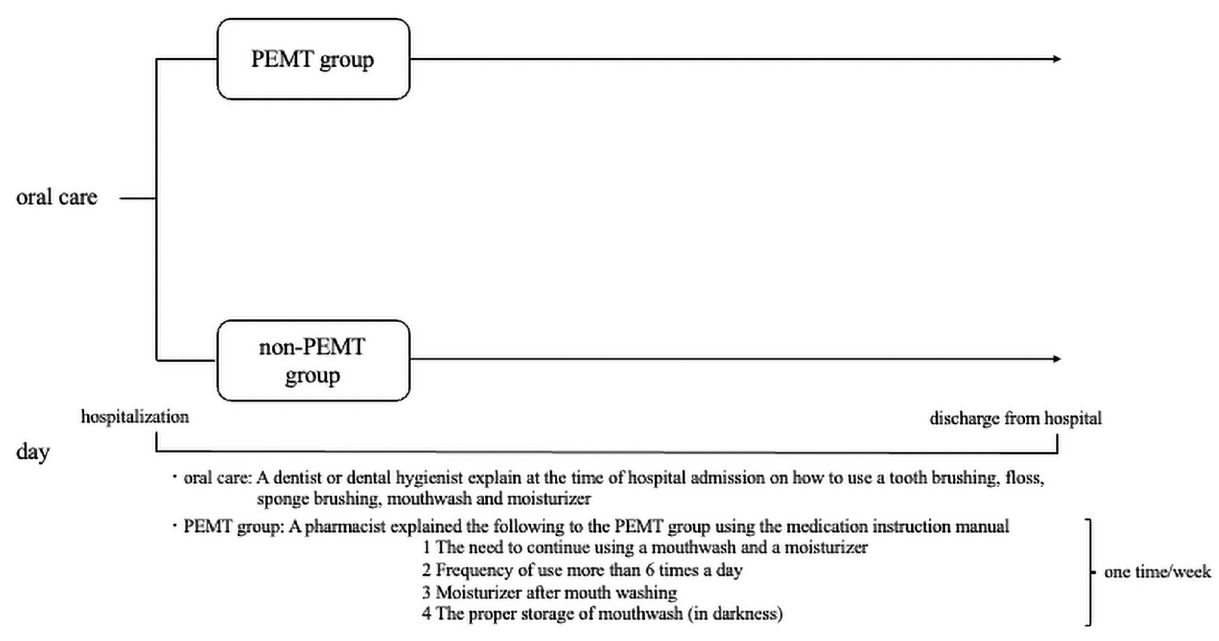
Fig 1. Education program by pharmacist’s involvement in the multidisciplinary